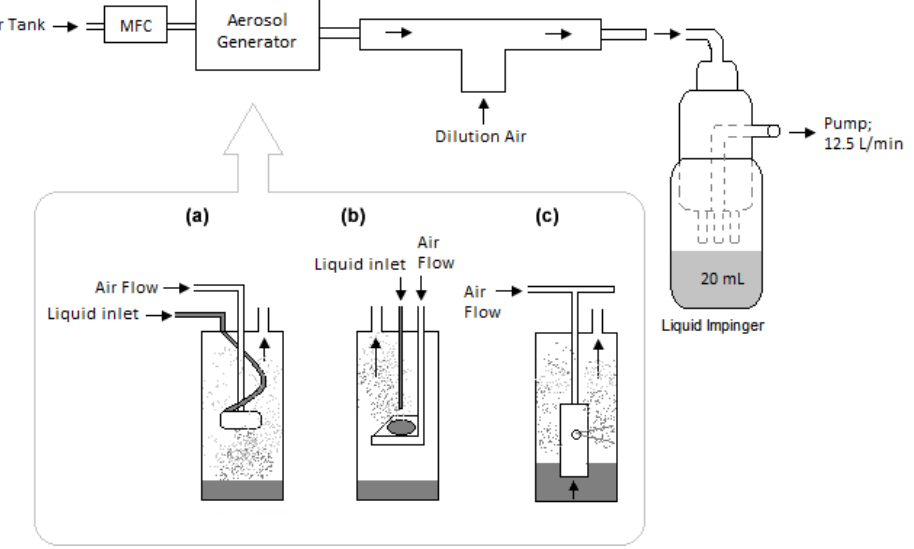
Figure 2. Experimental setup for the tests with the impinger. (a) BLAM, (b) SLAG, and (c) Collison.